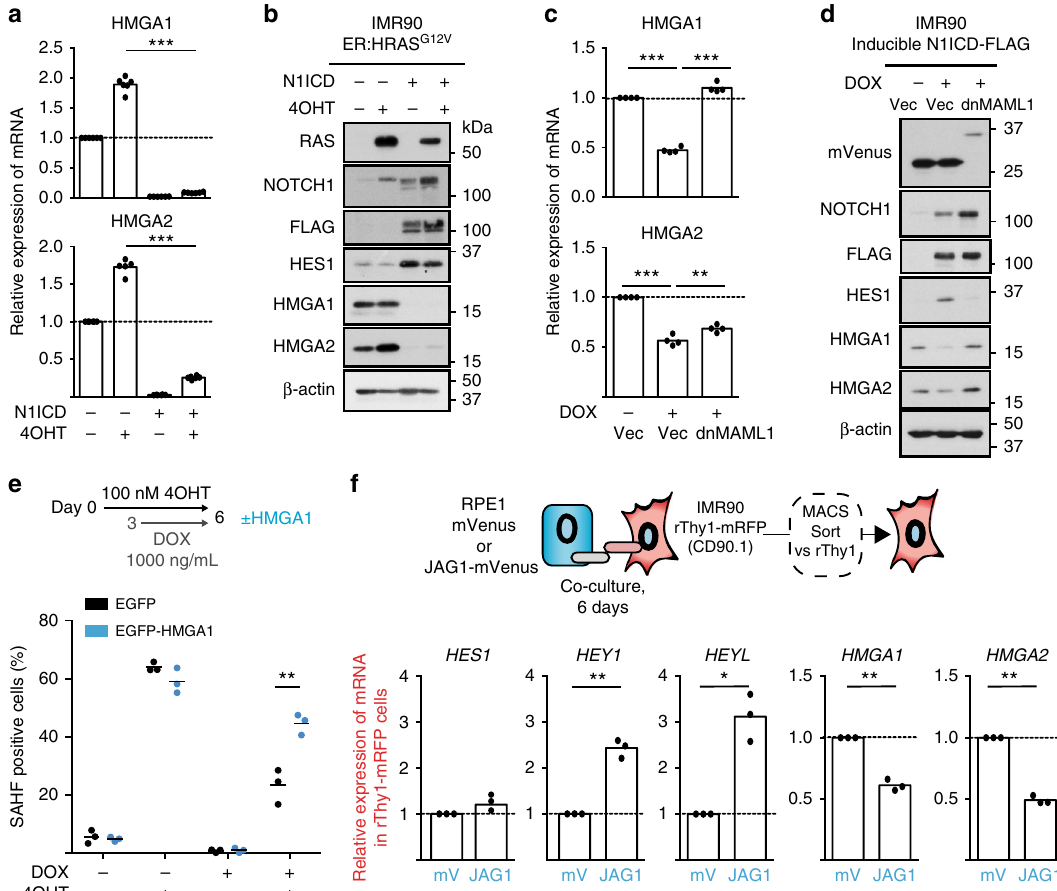
Fig. 3 NOTCH1 signalling represses SAHF formation partially by repressing HMGA proteins. a , b qRT-PCR ( n = 6) ( a ) and immunoblotting ( b ) for the indicated mRNA and proteins in IMR90 ER:HRAS G12V cells stably infected with control vector or N1ICD-FLAG ± 100 nM 4OHT for 6 days. c , d qRT-PCR ( n = 4) ( c ) and immunoblotting ( d ) of IMR90 cells expressing doxycycline (DOX)-inducible N1ICD-FLAG (iN1ICD) and infected with a mVenus control vector or dnMAML1-mVenus ± 1000 ng/mL DOX for 3 days. e Quanti fi cation of SAHFs in IMR90 cells expressing ER:HRAS G12V , iN1ICD and EGFP or an EGFP- HMGA1 fusion ± 100 nM 4OHT for 6 days and ±1000 ng/mL DOX for 3 days. f qRT-PCR for the indicated mRNA in IMR90 cells expressing rThy1-mRFP and co-cultured with RPE1 cells expressing mVenus or JAG1-mVenus, isolated using MACS ( n = 3). Statistical signi fi cance calculated using one-way ANOVA with Tukey ’ s correction for multiple comparisons ( a , c ) or two-sample t -test ( e , f ). * p ≤ 0.05, ** p ≤ 0.01, *** p ≤